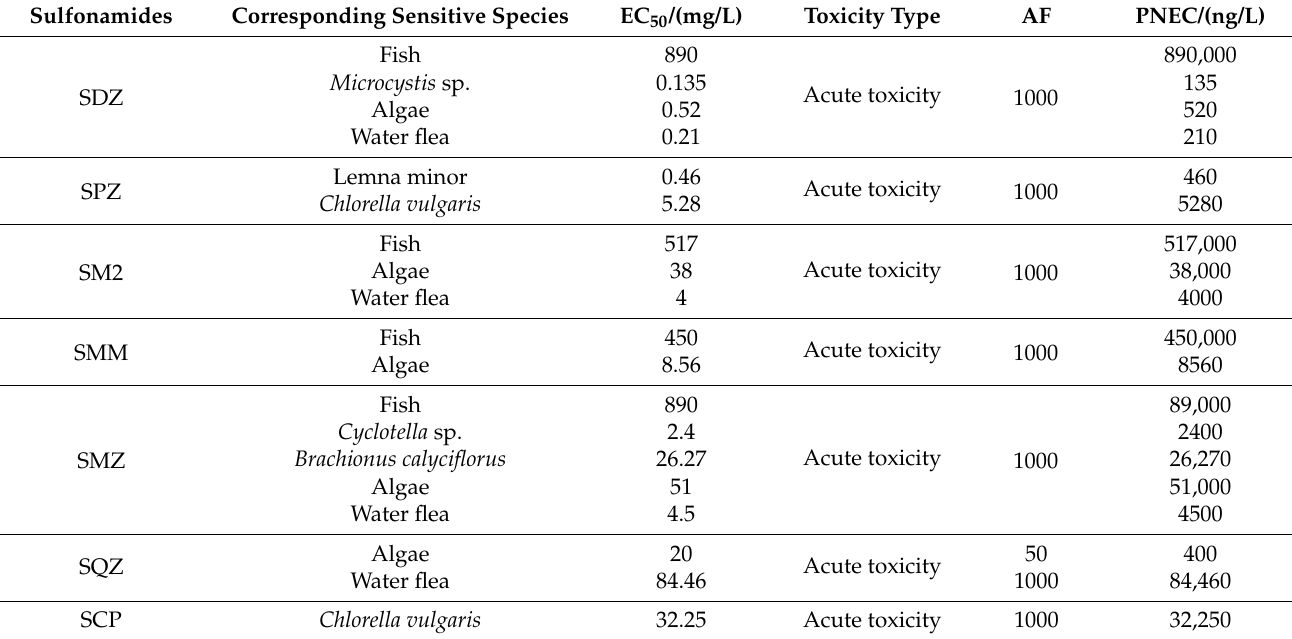
Table 1. Toxicity data and PNEC values for sensitive species to antibiotics.